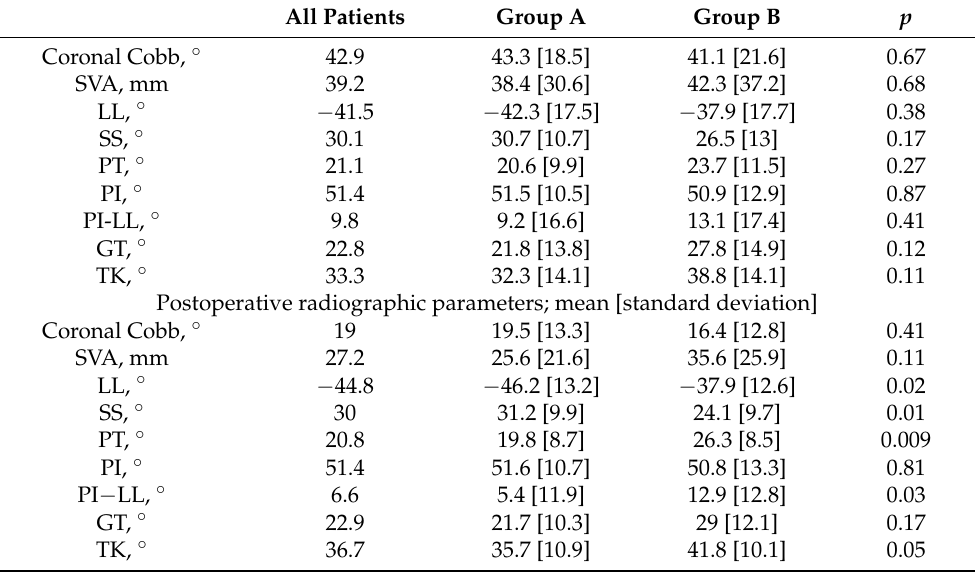
Table 4. Preoperative radiographic parameters; mean [standard deviation].